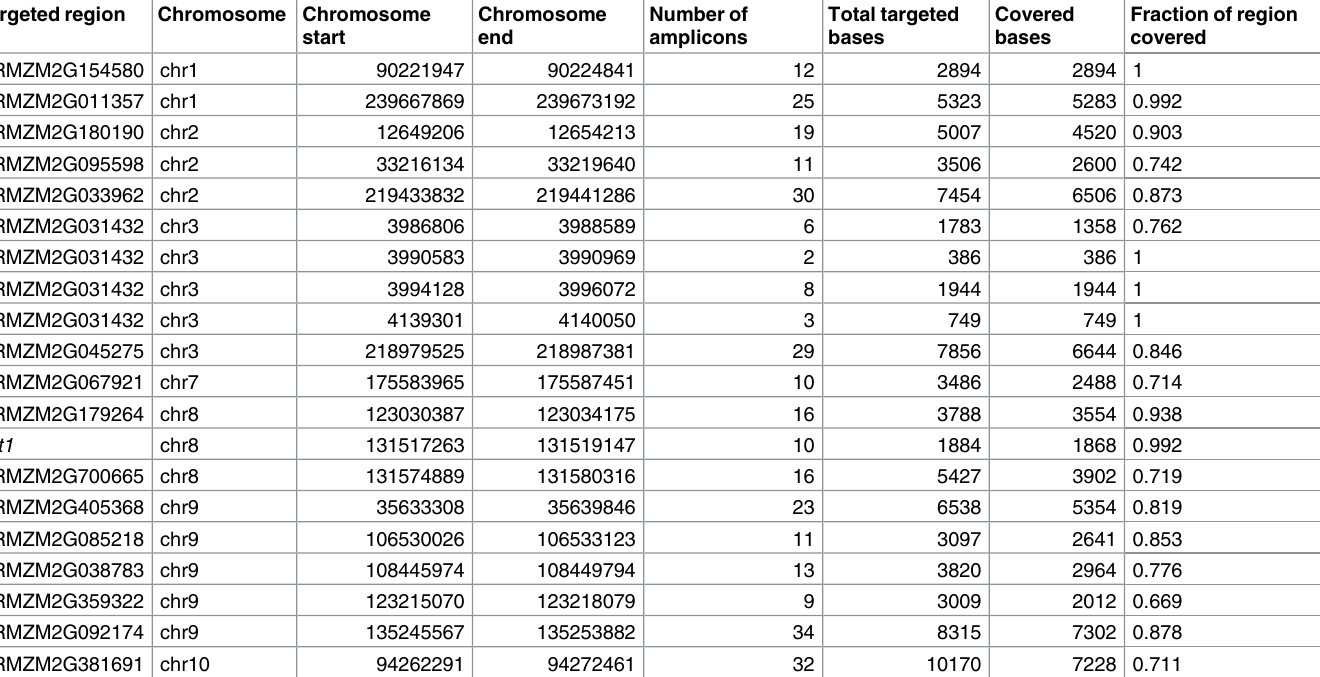
Table 1. Regions targeted by Ampliseq design. Targeted regionsof interest are shown, along with the numberof ampliconsand coveragefor each region. Targeted